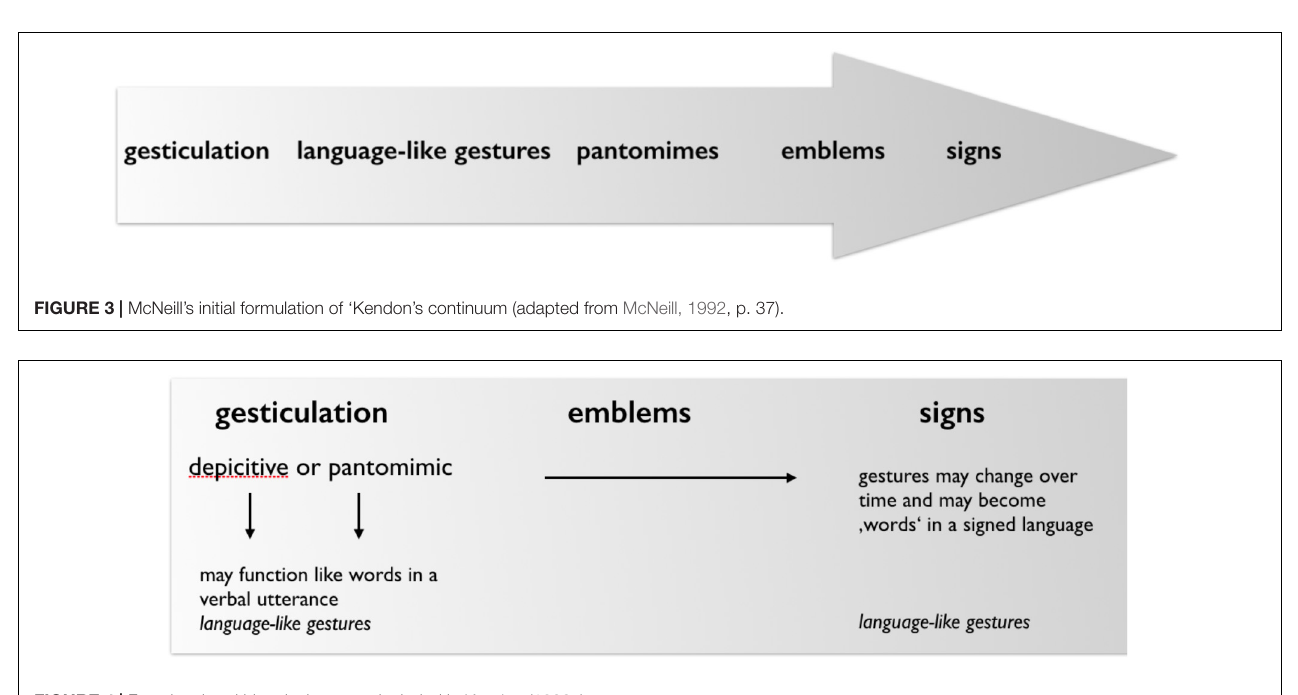
FIGURE 4 | Functional and historical aspects included in Kendon (1988a).